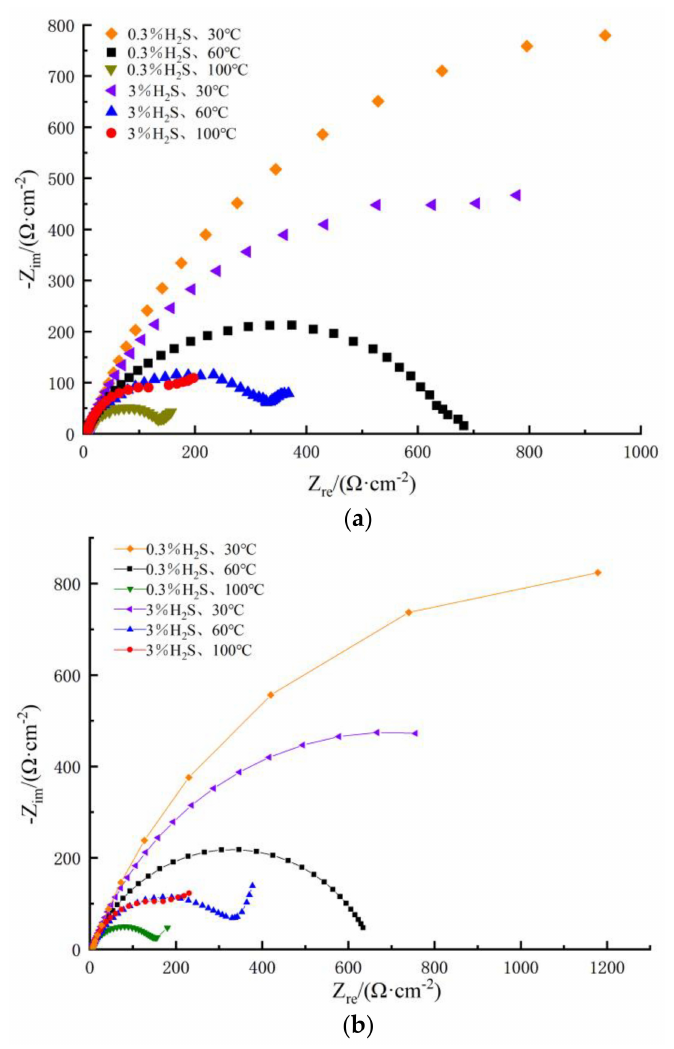
Figure 9. AC impedance spectra of 80S steel at different sulfur contents and different temperatures. ( a ) Measured curves ( b ) Fitting the